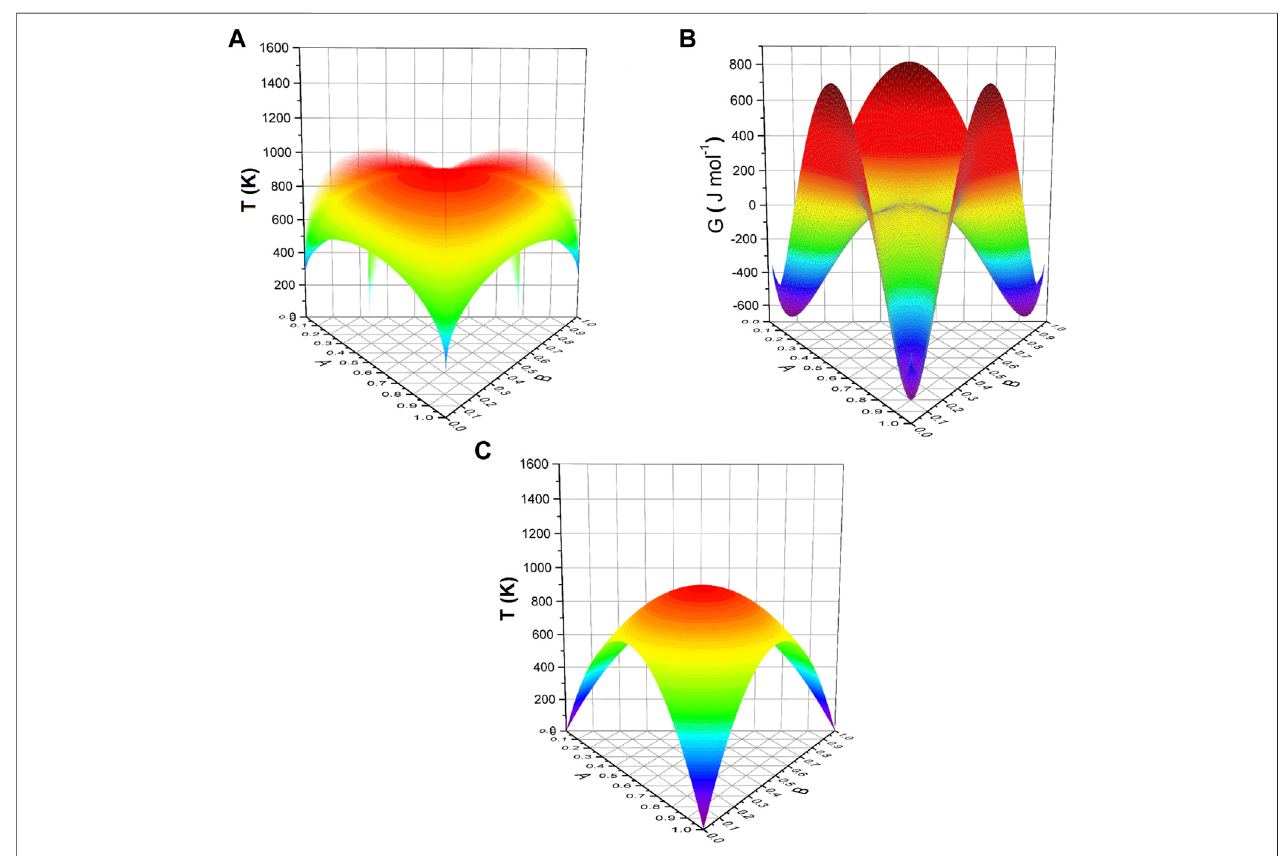
FIGURE 1 | (A) Miscibility gap, (B) free energy curve, and (C) spinodal curve for the A – B – C alloy system, respectively, for Ω AB = Ω BC = Ω CA = 25,000 J/mol at 900 K.